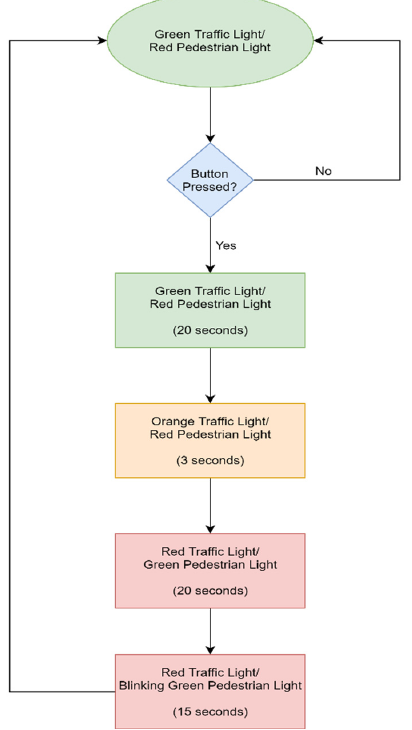
Figure 1. Flowchart of behaviors of the traffic light system.